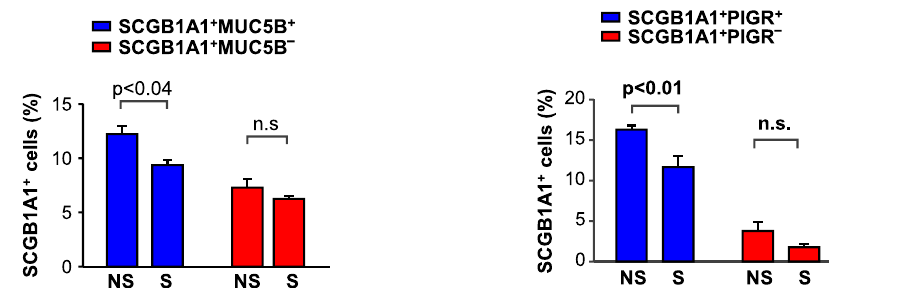
Fig. 7 Smoking-induced, asymmetric decrease in club cell heterogeneity in small airway epithelial (SAE) cells brushed from the small airway of healthy nonsmokers or healthy smokers. a Immuno fl uorescence analysis of cytopreps containing club cells (SCGB1A1 + ) expressing the effector club cell genes PIGR or MUC5B. White arrowheads indicate dual-labeled cells. White arrows indicate SCGB1A1 + club cells that lack signi fi cant expression of a PIGR or MUC5B. Black arrows mark examples of SCGB1A1-negative non-club cells in the cytoprep. Bar = 20 µm. b Total number of dual labeled (SCGB1A1 + PIGR + or SCGB1A1 + MUC5B + ) cells, or SCGB1A1 single labeled cells were quanti fi ed by a blinded observer in nonsmokers and compared with smokers. Plot shows mean of three experiments ± standard error; p values are from a two-sided unequal variance Student ’ s t